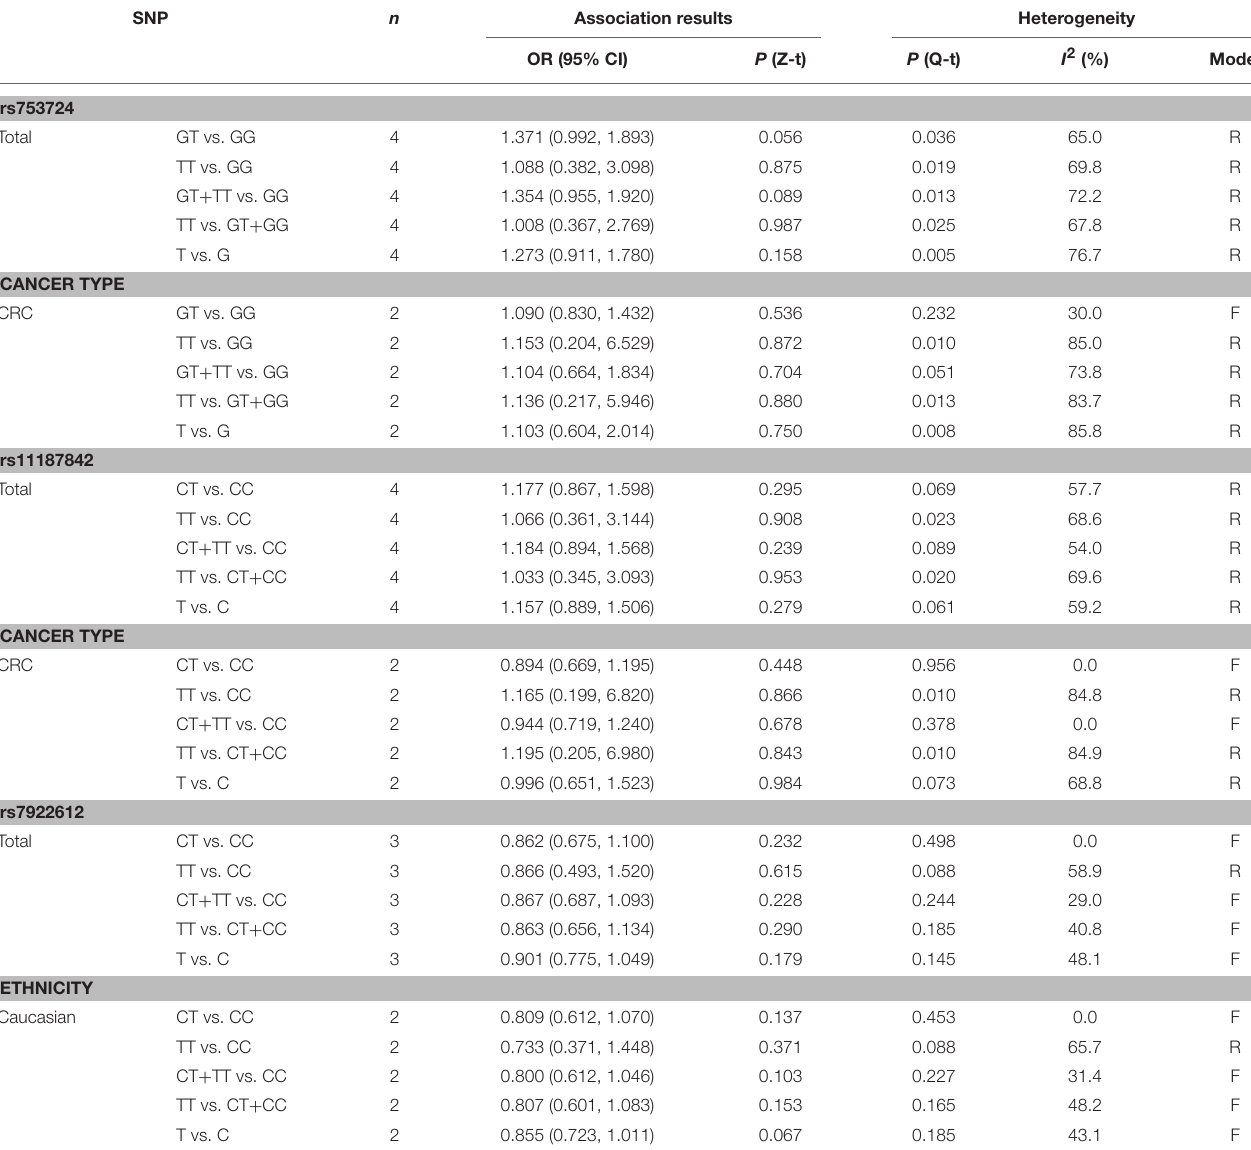
TABLE 4 | Meta-analysis of the relationship between PLCE1 rs753724, rs11187842, rs7922612 polymorphisms and cancer risk. SNP n Association